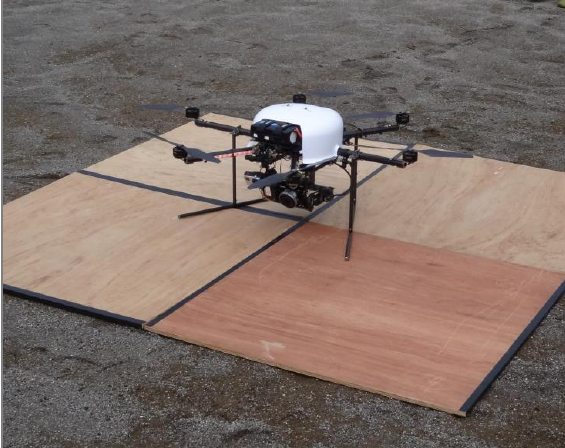
Figure 1. Muticopter on the take-off and landing field